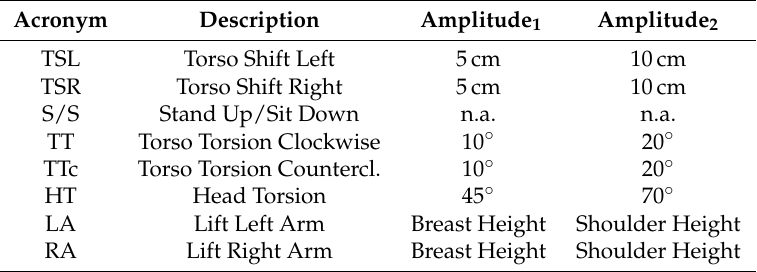
Table 2. Motion protocol. Amplitude values were given as instructions to the subject. No amplitude variation was performed for stand up/sit down maneuver. Modified from